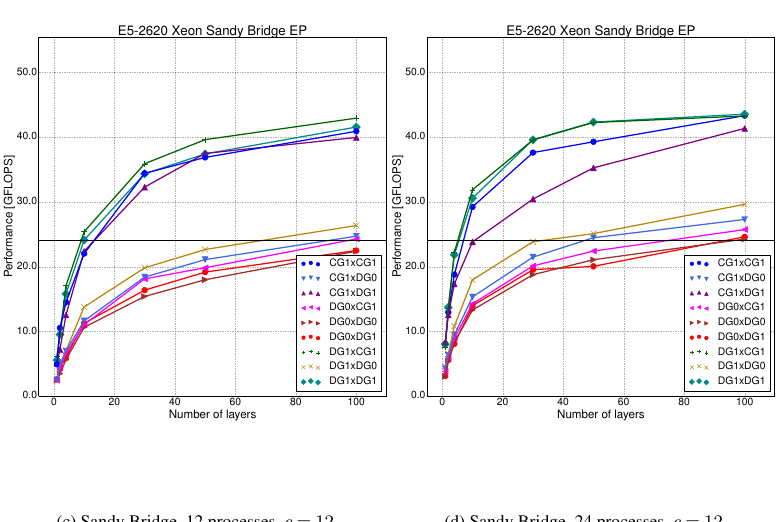
Figure 6. Performance of the I integral computation with varying number of layers and number of processes on a badly-ordered base mesh. The horizontal line is the base FLOP throughput for f b = f v = 1 and the number of physical cores used.